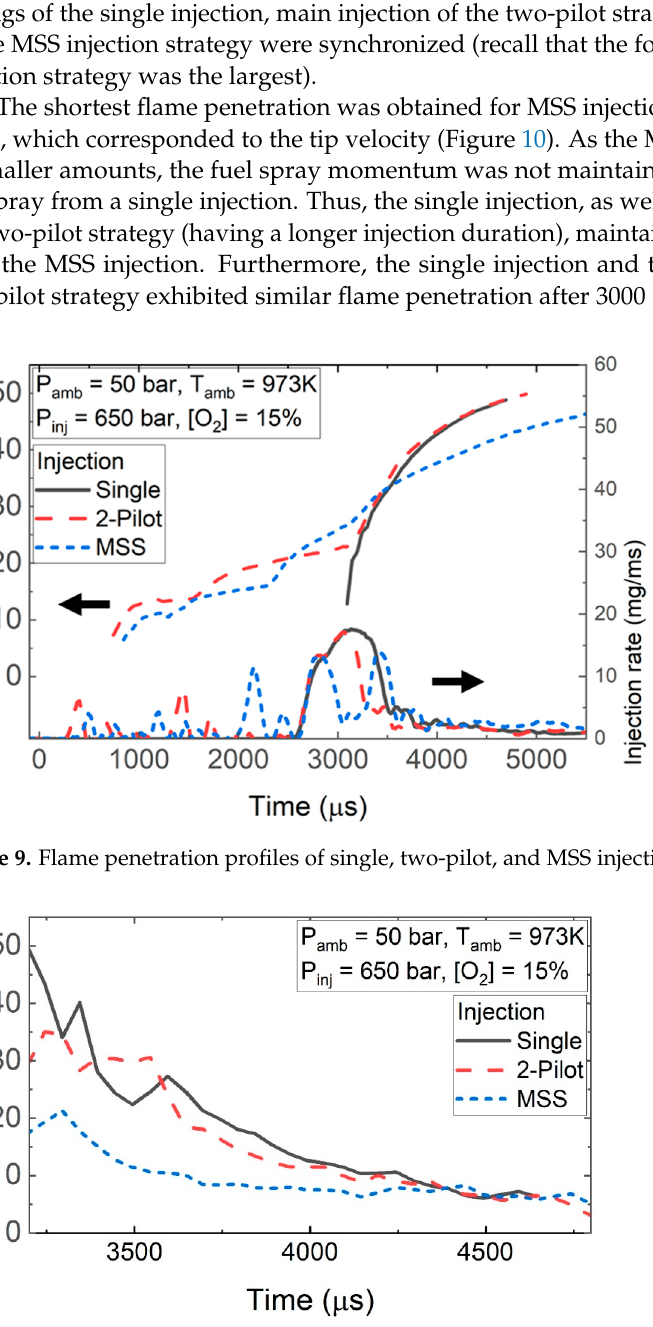
Figure 10. Flame tip velocities of the single, two-pilot, and MSS injection strategies.